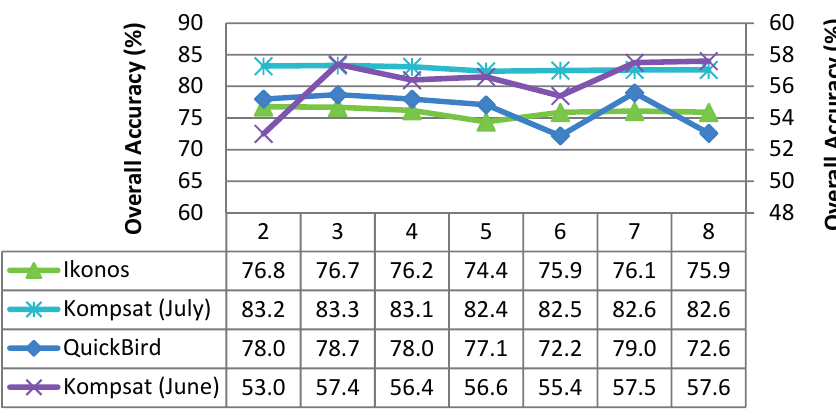
Figure 11. Overall accuracy vs. number of components of GMM. (The results of Kompsat-2 June image are presented on the right-y axis to improve visibility).